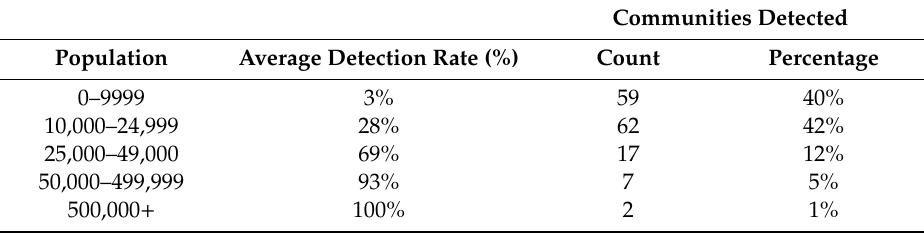
Table 2. Detection rate of communities in Burkina Faso in DMSP-OLS nighttime light data by Table2. population.